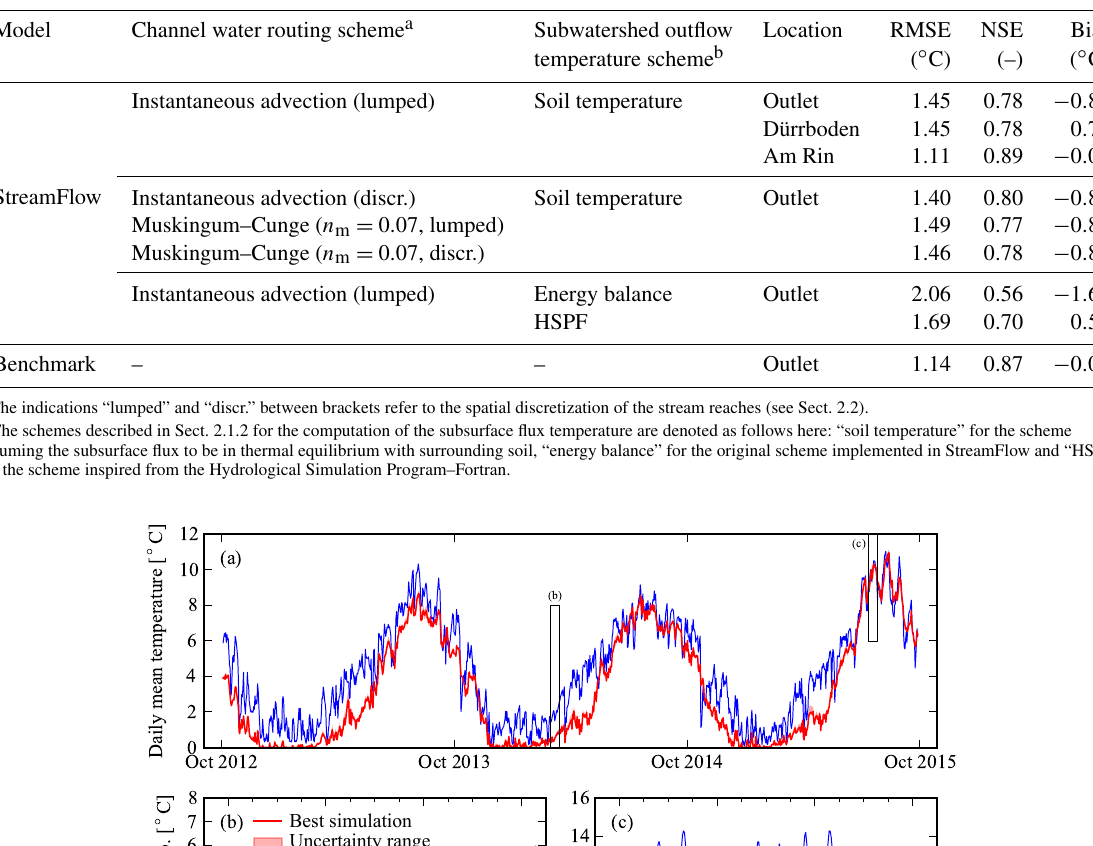
Table 5. Accuracy of the hourly stream temperature predictions of StreamFlow (with z d = 2 . 40m), based on various approaches for advecting water in the stream channels and computing the temperature of the subsurface water flux. The accuracy of the temperature benchmark model at the catchment outlet is indicated in the last row for comparison. All error measures are computed over the entire validation period (1 October 2013 to 1 October 2015), except at points Am Rin and Dürrboden for which the considered time period is the same as in Table 4.